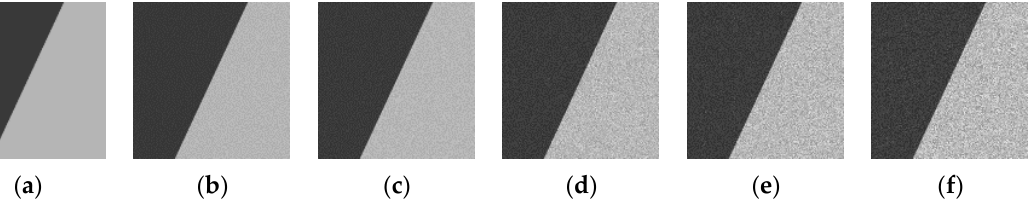
SNR BNDE images (3.9, 4.2, 4.8, 10.0, 12.6) were obtained by adding noises with different images with different noise levels are shown in Figure 4.